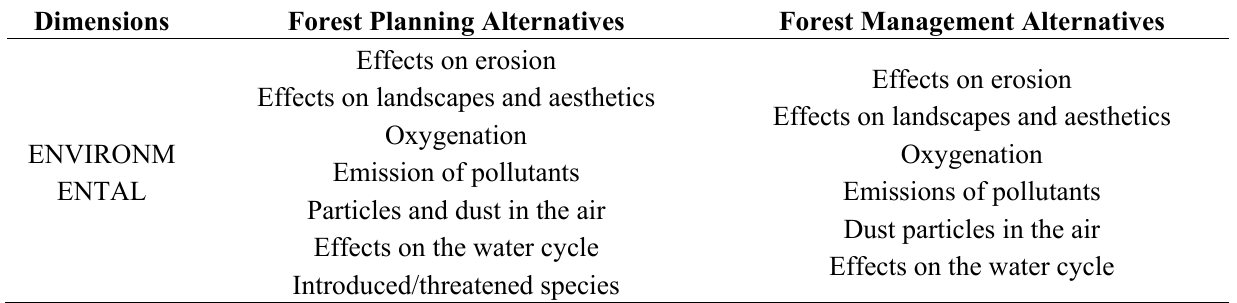
Table 4. Criteria to assess both planning and management